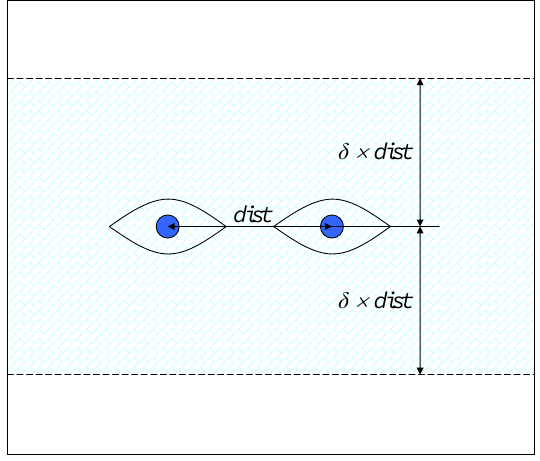
Figure 6. Eyeglasses search area. The eyeglasses search space is fixed to a region surrounding the eyes.